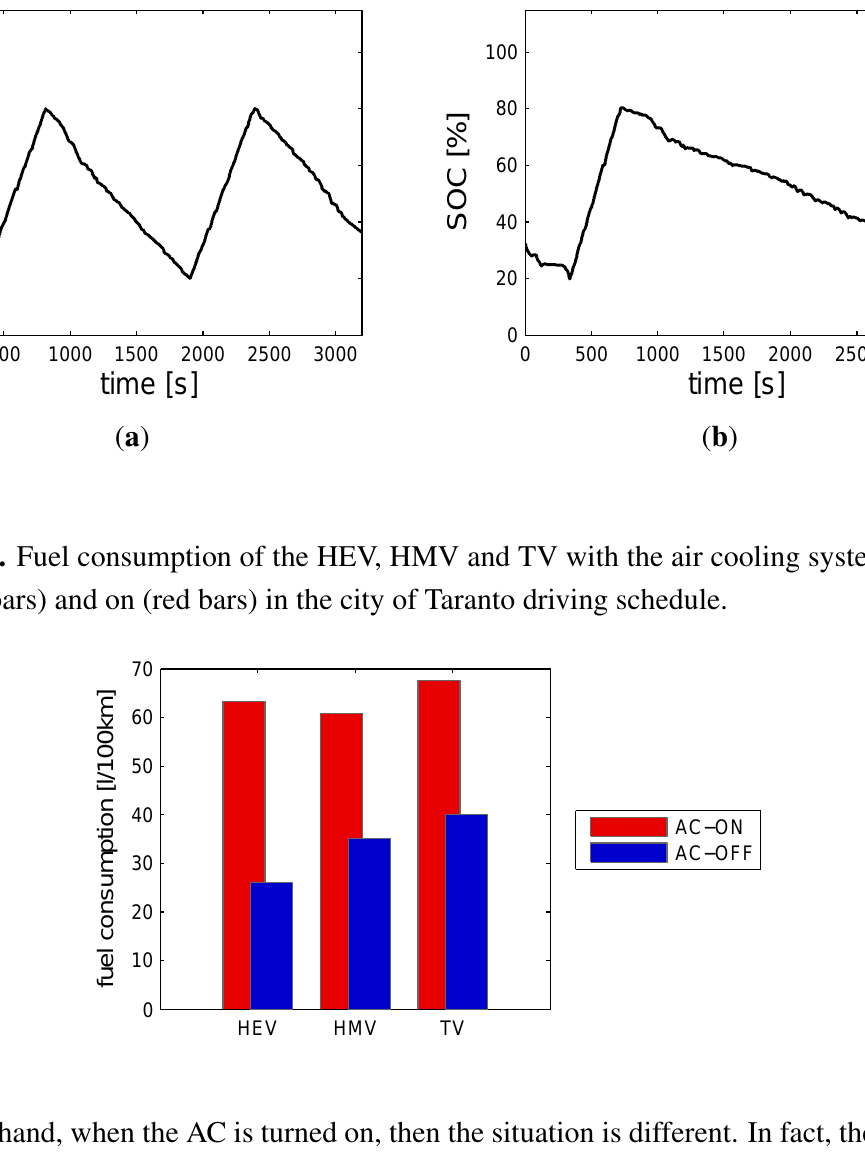
Figure 15. SOC of the batteries pack of the HEV. The air cooling system is turned ( a ) on and ( b ) off.